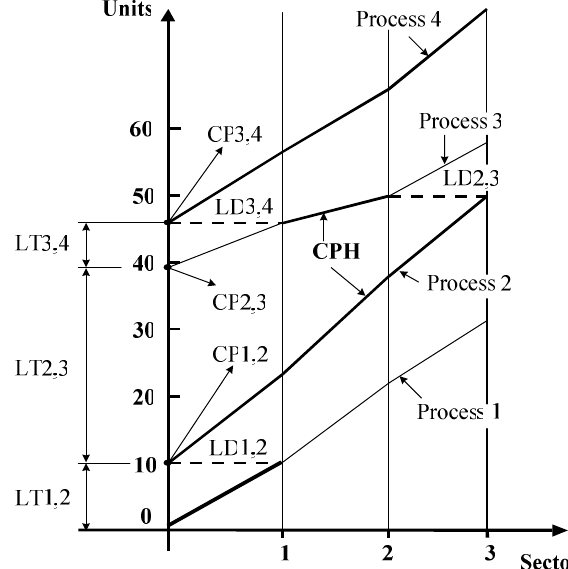
Fig 1. Symbols used to describe continuous processes (Process 1, … Sectors)